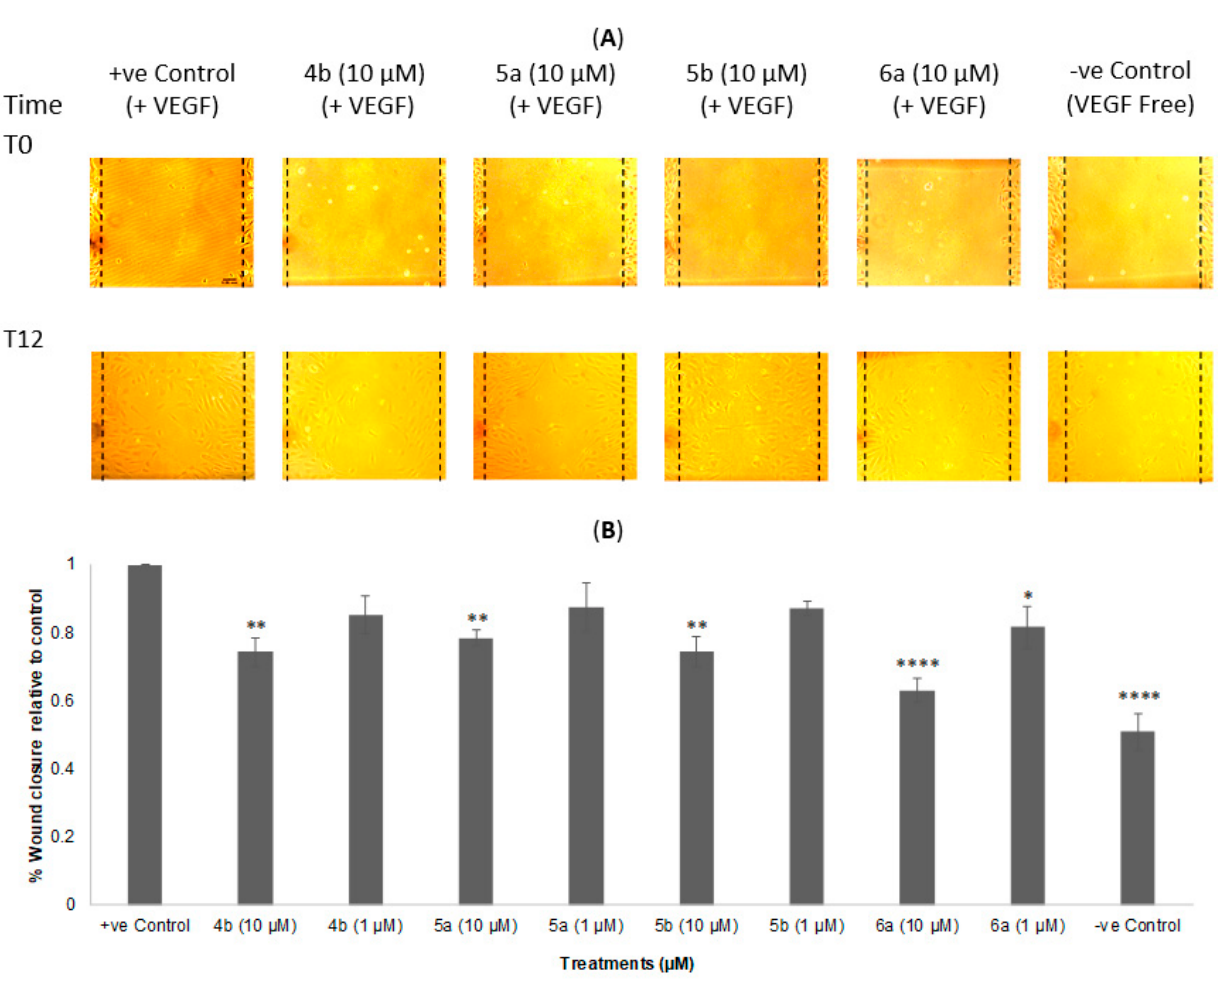
Figure 3. In vitro HUVEC wound closure (migration) inhibition activity of flavonoid derivatives ( 4b , 5a , b and 6a ) expressed as a ratio to the +ve control (10 ng/mL VEGF-enriched media). ( A ) Representative images of scratch assay at 0 h and 12 h at 10× magnification. Images were analysed using ImageJ software; ( B ) % wound closure after 12 h as a ratio to +ve control. Data are expressed as mean ± standard error of the mean (SEM), n = 3. Statistical significance was estimated with respect to the +ve control by one-way ANOVA, followed by Dunnett’s multiple comparison test (* p < 0.05, ** p < 0.01, **** p < 0.0001).